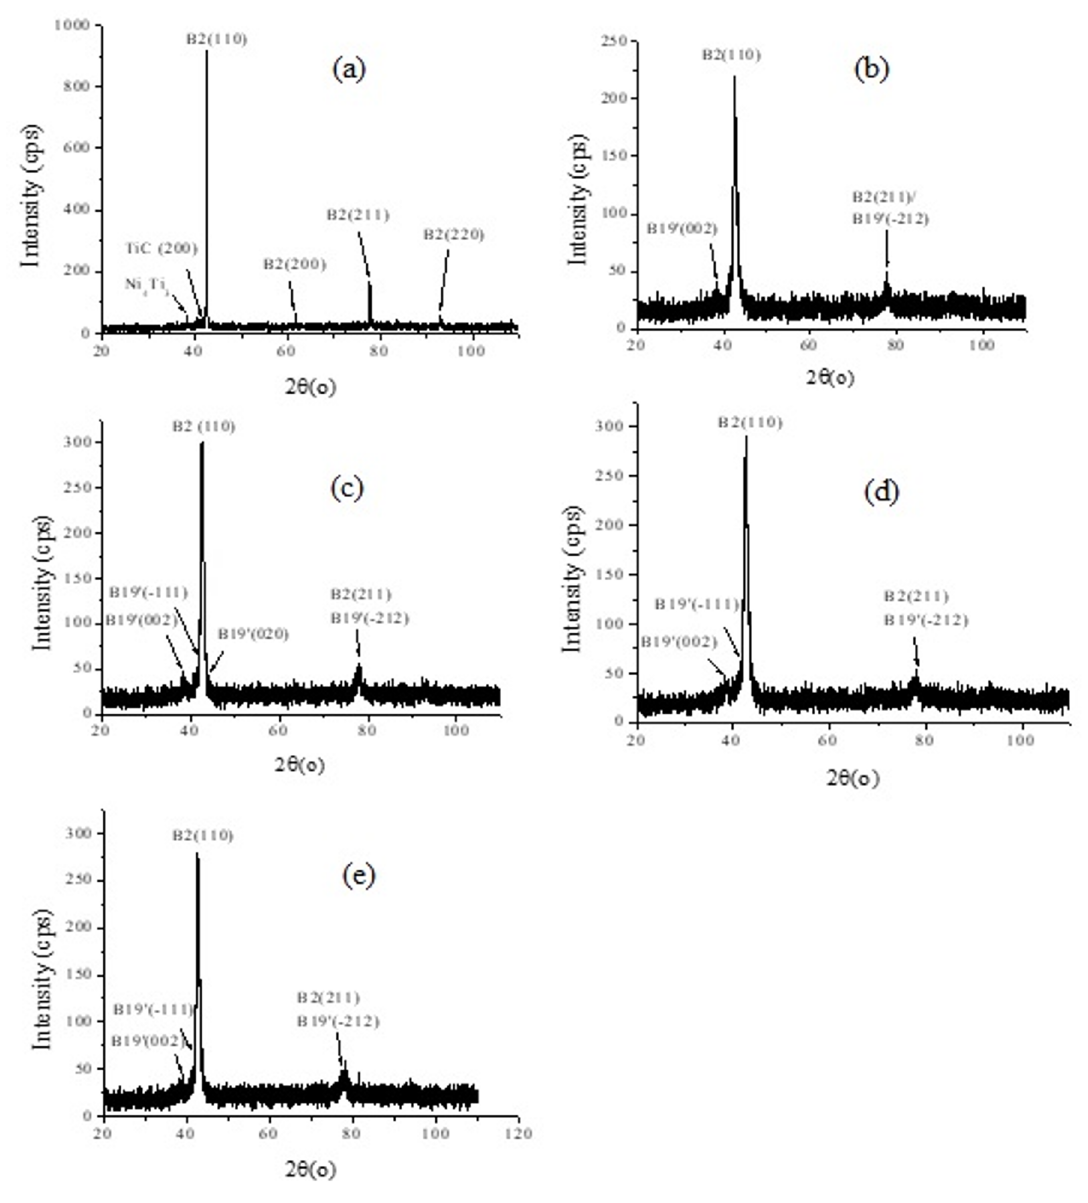
Figure 3. X ray diffraction patterns of (a) EQS, (b) EQSC, (c) EQSC150, (d) EQSC200, (e) EQSC250